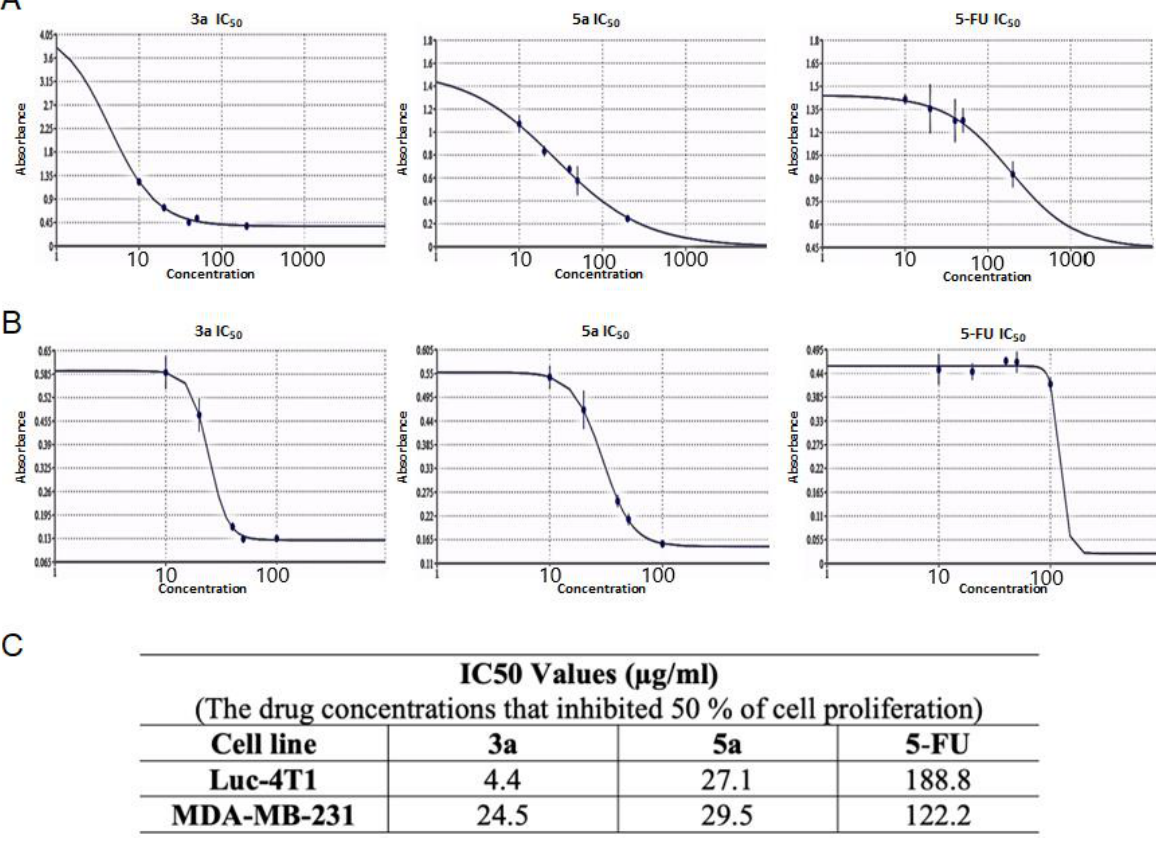
Figure 3. The IC50 values of the chalcone methoxy derivatives 3a and 5a. IC50 was determined through the MTT assay by non-linear regression using ( A ) Mouse Luc-4t1 and ( B ) Human MDA-MB-231 cell lines after 48 h of treatment, with 5-FU as a positive control against. ( C ) Summary of the IC50 values. The Quest Graph™ IC50 Calculator [29] was used to calculate the IC50.